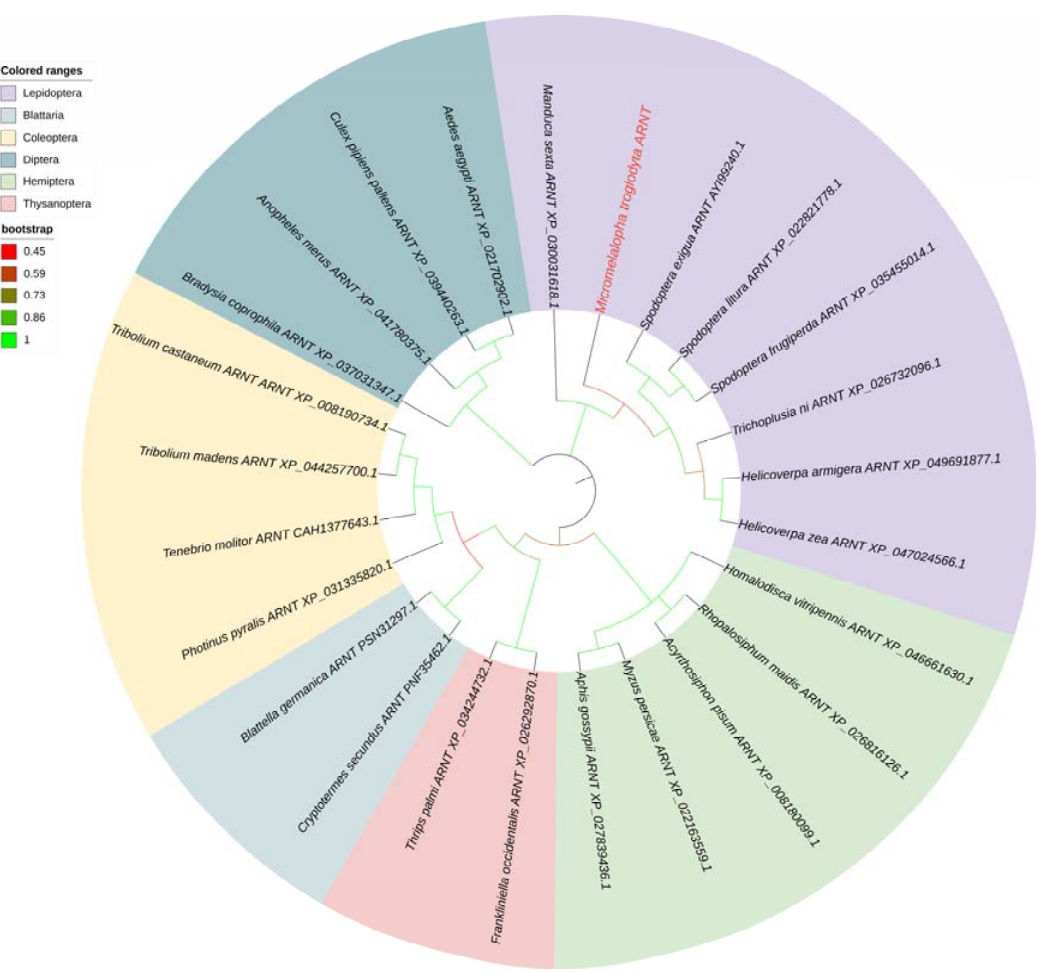
Figure 5. Phylogenetic analysis of the ARNT sequences of several insect species. The ARNT gene name was shown as the Latin name of the species, ARNT and the NCBI gene accession number, and the M. troglodyta ARNT was marked in red and bold. The branches for Lepidoptera, Diptera, Blattodea, Coleoptera, Hymenoptera, and Thysanoptera ARNTs were shaded in different colors, and branch colors represented bootstrap values.